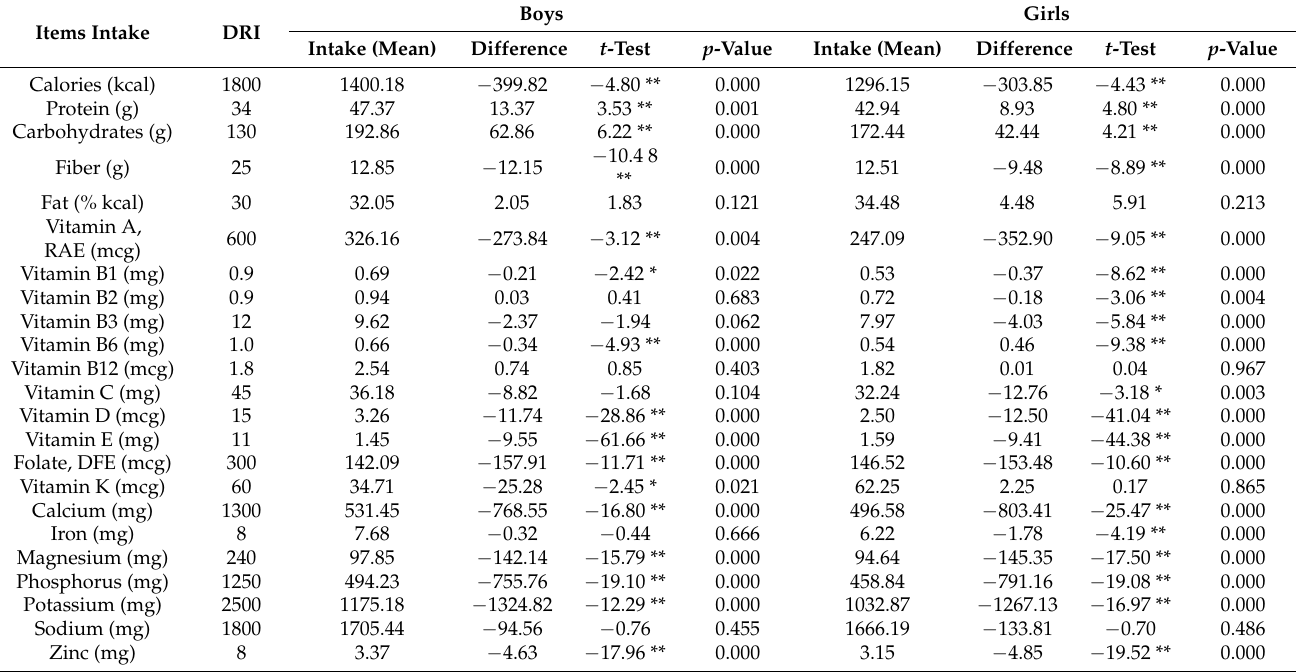
Table 2. The average nutrient intake in relation to dietary reference intakes (DRI) for children with CD following the Ministry of Health GFD